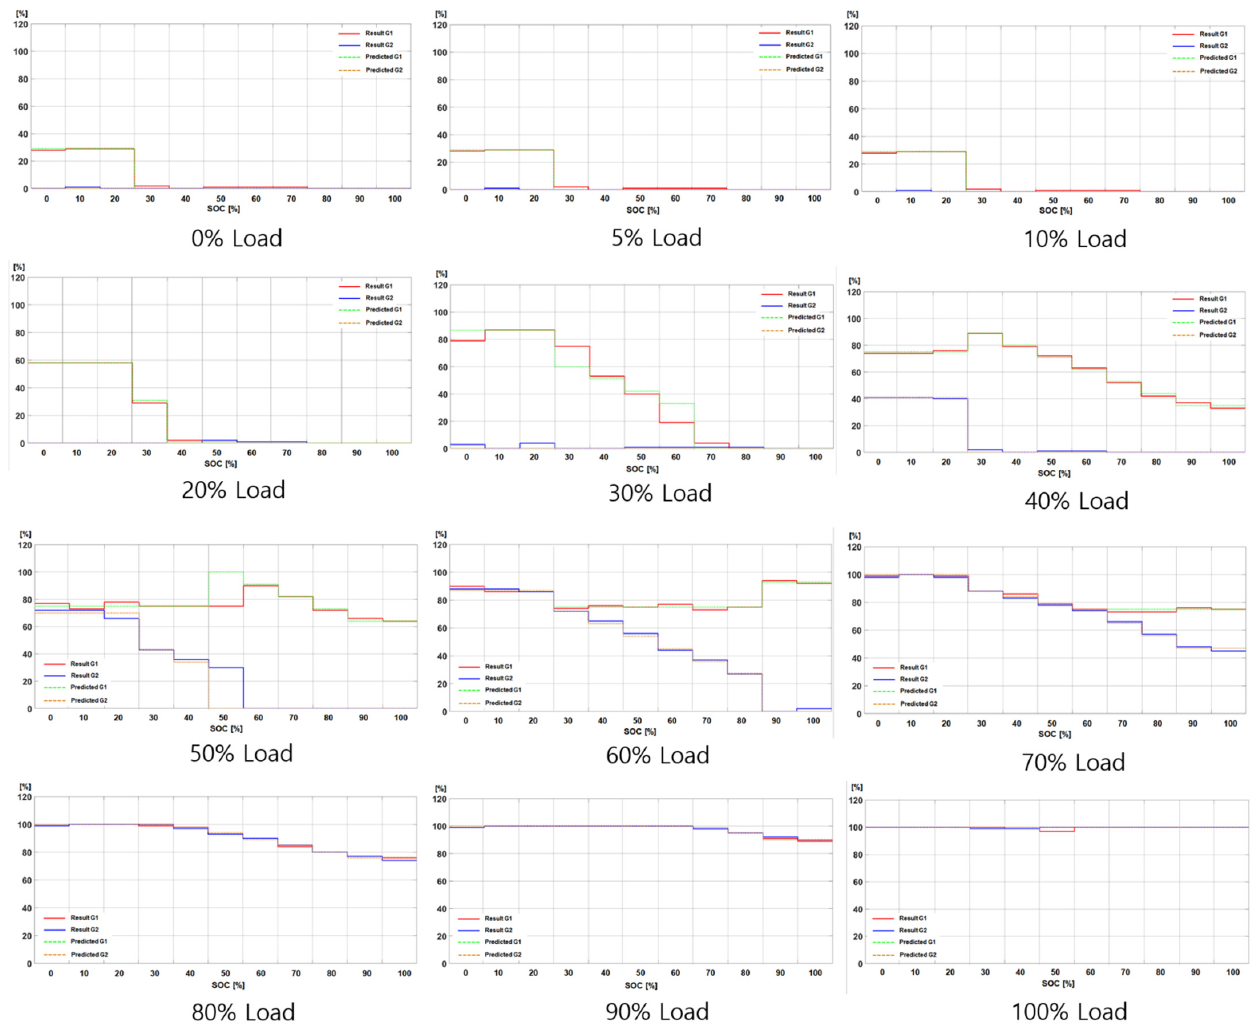
Figure 13. Design values and verification results of proposed neural network controller.